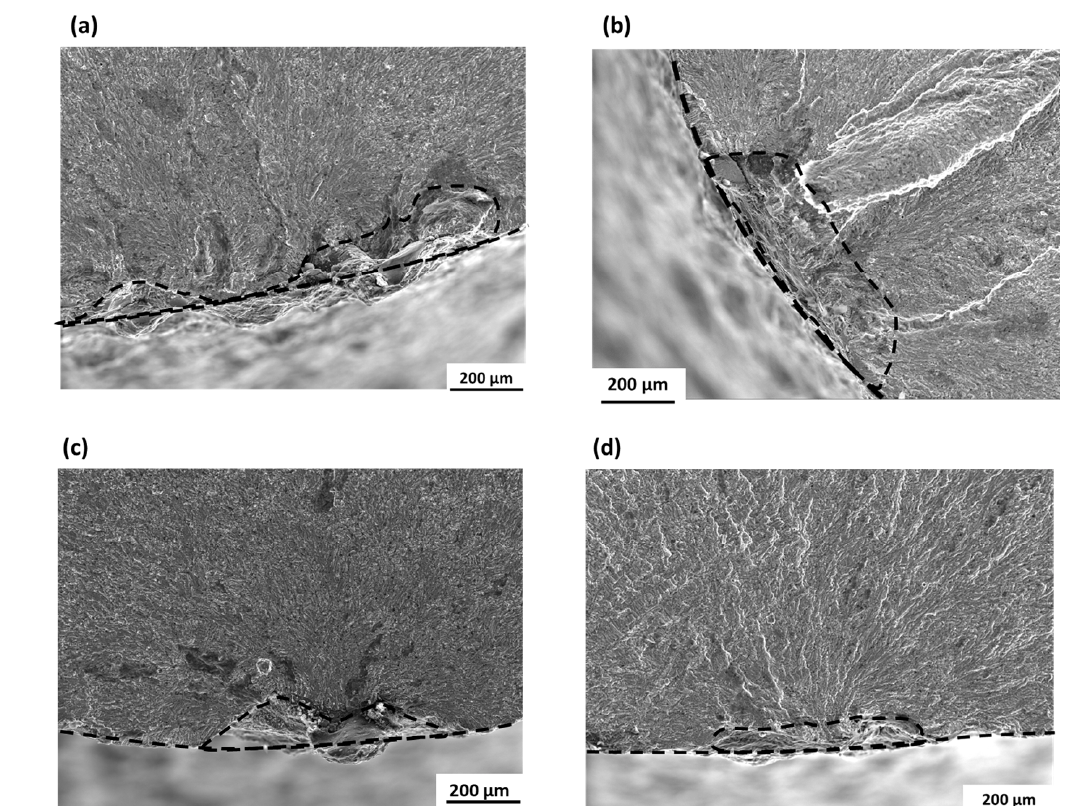
Figure 7. SEM observations ( a ) Z sample, as-built surface roughness and lack-of-fusion-type defect, σ max = 80 MPa , Nf = 330,000 cycles, ( b ) Z sample, lack-of-fusion-type defect, 90 MPa, 180,000 cycles, ( c ) XY sample, as-built surface roughness, 80 MPa, 275,000 cycles and ( d ) alpha45, sub-surface sur- face defect, 90 MPa, 90,000 cycles.